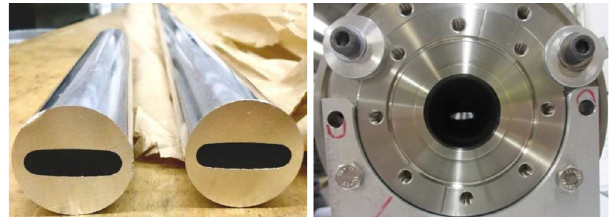
FIG. 15. Results of the Radia model simulation of the HSCU 13.5 period model. Top left: Vertical field. Top right: Horizontal field. Bottom left: Vertical first field integral. Bottom right Horizontal first field integral.